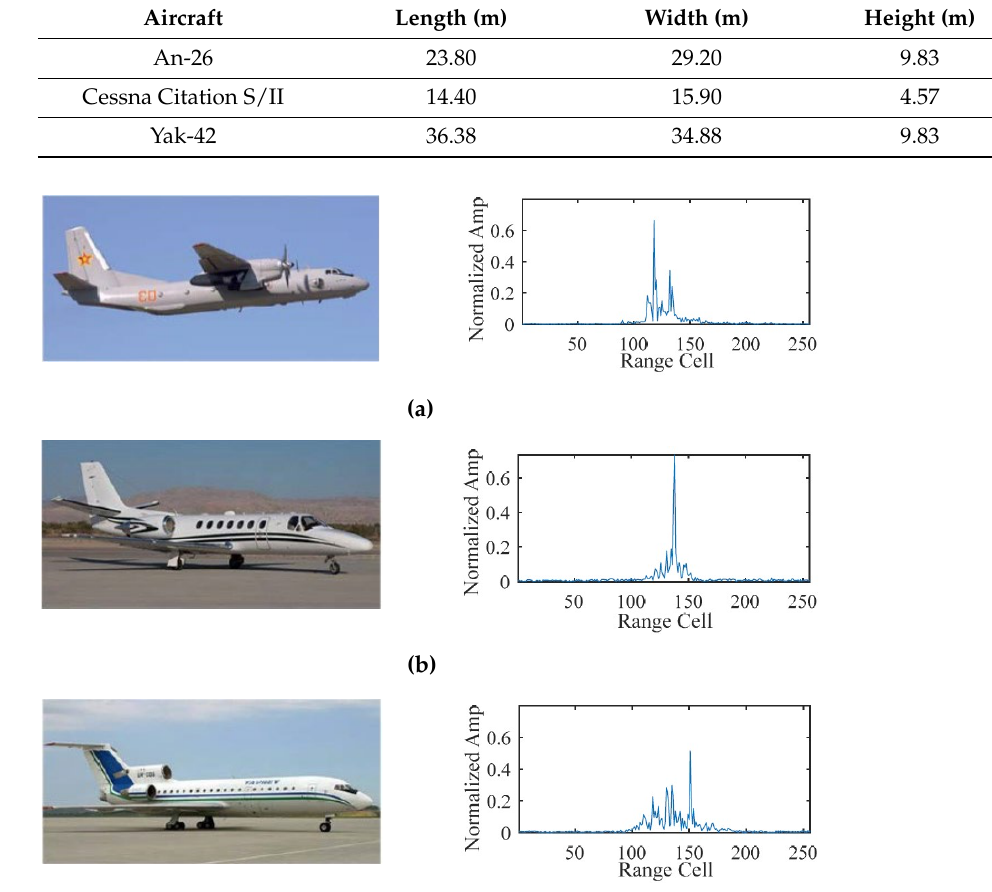
( c ) Figure 7. Projections of the trajectories on the ground. ( a ) An-26; ( b ) Cessna Citation S/II; ( c )Yak-42. Table 2. The number of samples for each data segment of the three aircrafts. Aircraft/No. — As a matter of routine [16,18,27–30], the training set is constructed by sampling the 5th and the 6th HRRP segments of An-26, the 6th and the 7th HRRP segments of Cessna Citation S/II, and the 2nd and the 5th HRRP segments of Yak-42, whereas the test set is constructed by sampling the rest HRRP segments. Moreover, the sampling interval is 20, and the number of training and test samples is 7398 and 16,656, respectively. Such settings